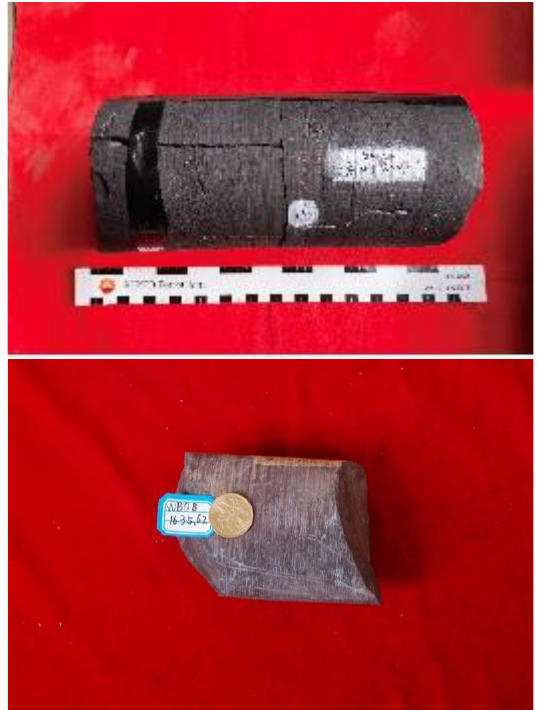
Figure 2. Core samples of shale.